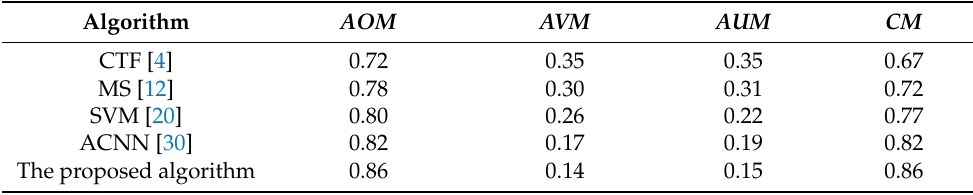
Table 3. Cloud detection results of database 2.